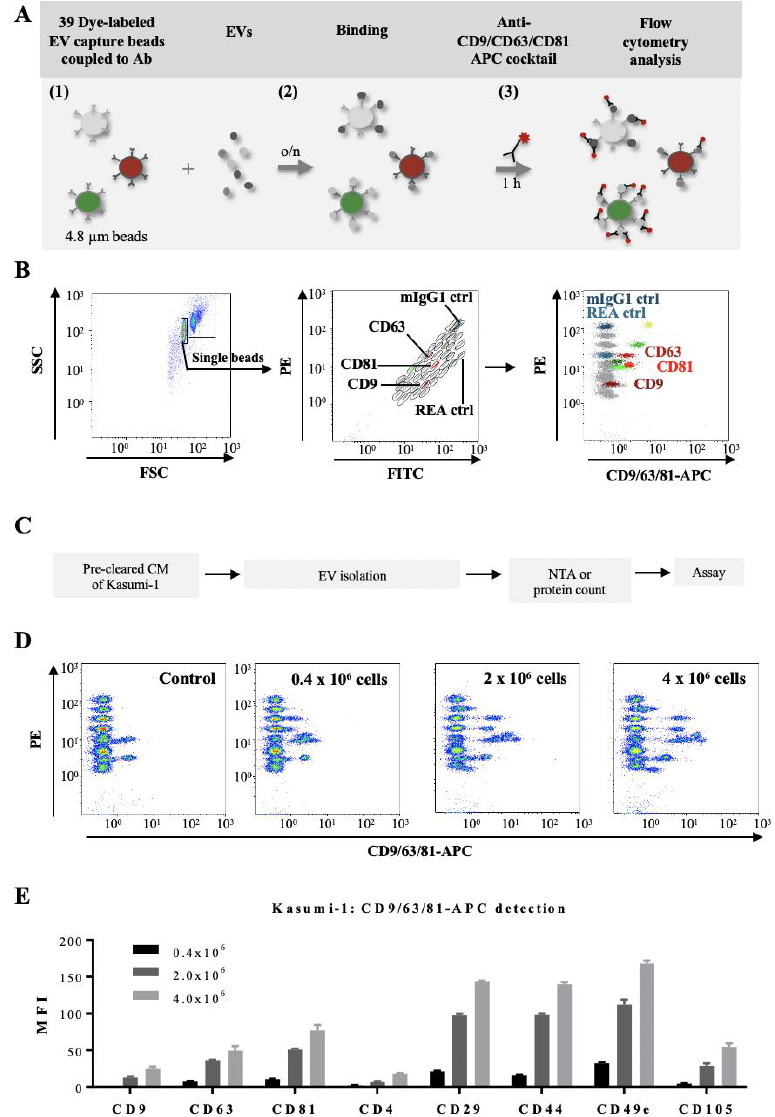
Figure 3. Multiplex bead-based flow cytometry assay: simultaneous detection of 39 different anti- gens on EVs: ( A ) Schematic representation of the multiplex bead assay, based on a cocktail of 39 fluorescently-labelled bead populations (MACSPlex Exosome Capture beads, 4.8 µm) that can be